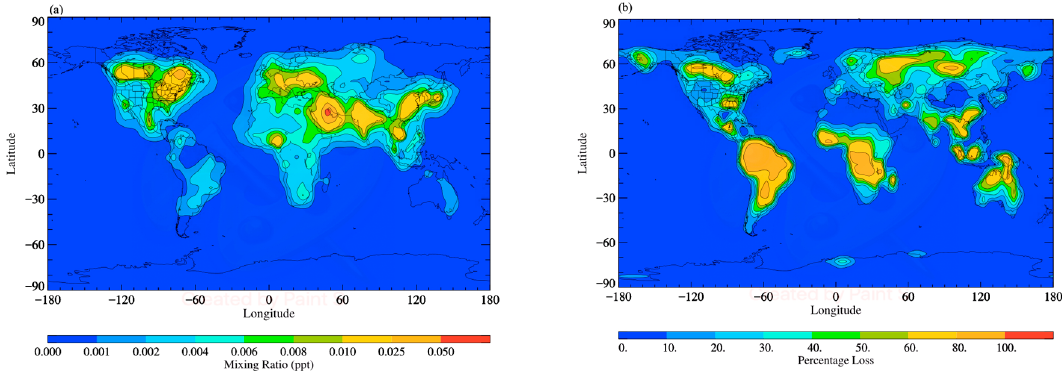
Figure 1. The surface distribution plot depicting the surface level ( a ) mixing ratios of PFOA in ppt simulated by STOCH-DE; ( b ) percentage of PFOA removed as a result of its reaction with stable Criegee intermediates (SCIs) simulated by STOCH-CI.